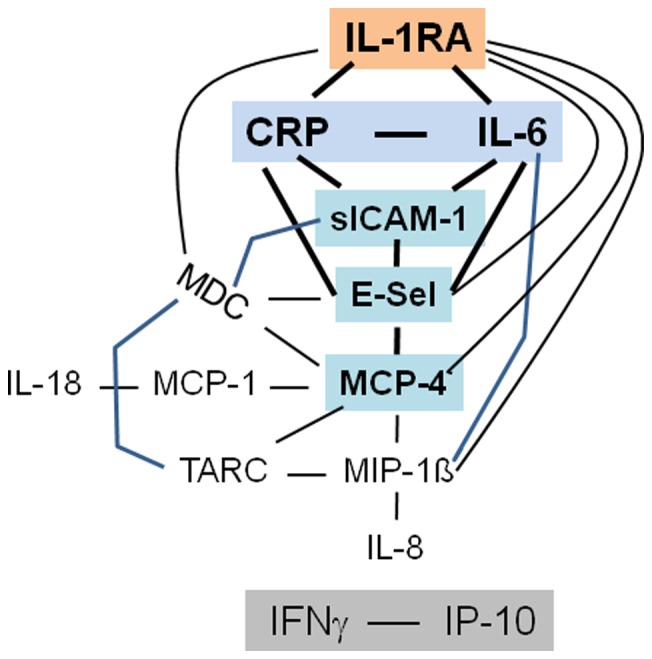
Systemic immune mediator network in patients with recent onset type 1 diabetes.Shown are all significant correlations (p<0.05) between single immune mediators, Spearman rank correlation test. Lines crossing other lines are indicated in blue. Stronger lines indicate associations between central elements of the network. Central elements and the second network are shaded for better readability. Correlation coefficients are listed in Table 1.